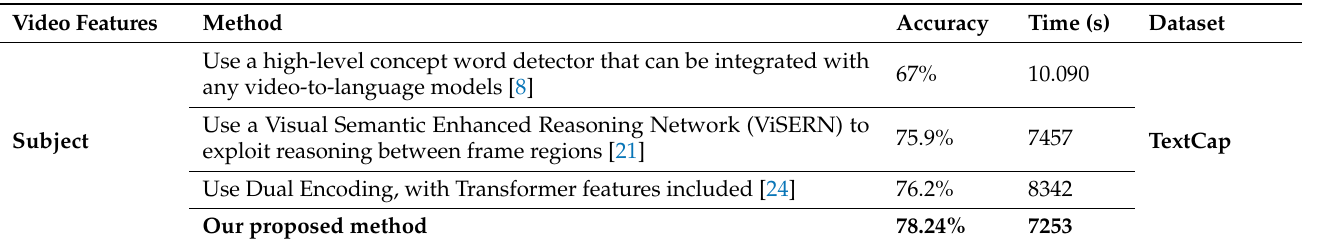
Table 5. Comparison of content-based video retrieval